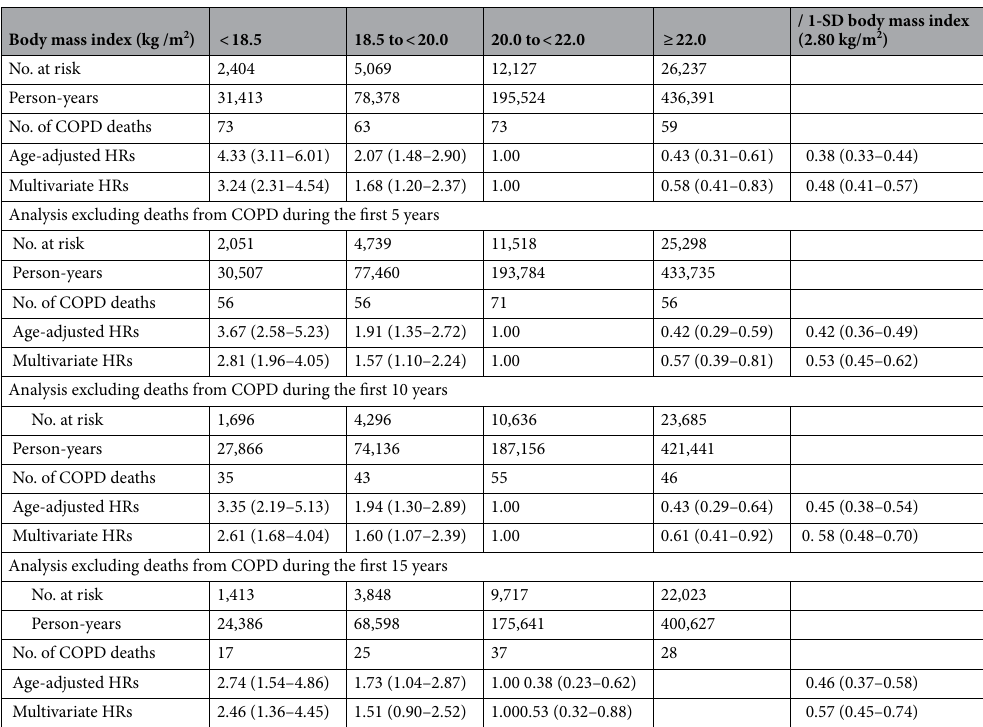
Table 2. Hazard ratios (HRs) and 95% confidence intervals of COPD mortality according to body mass index. Multivariate adjustment for age, weight change from the age of 20, ethanol intake, hours of walking, hours of exercise, education history, smoking index, and disease histories.